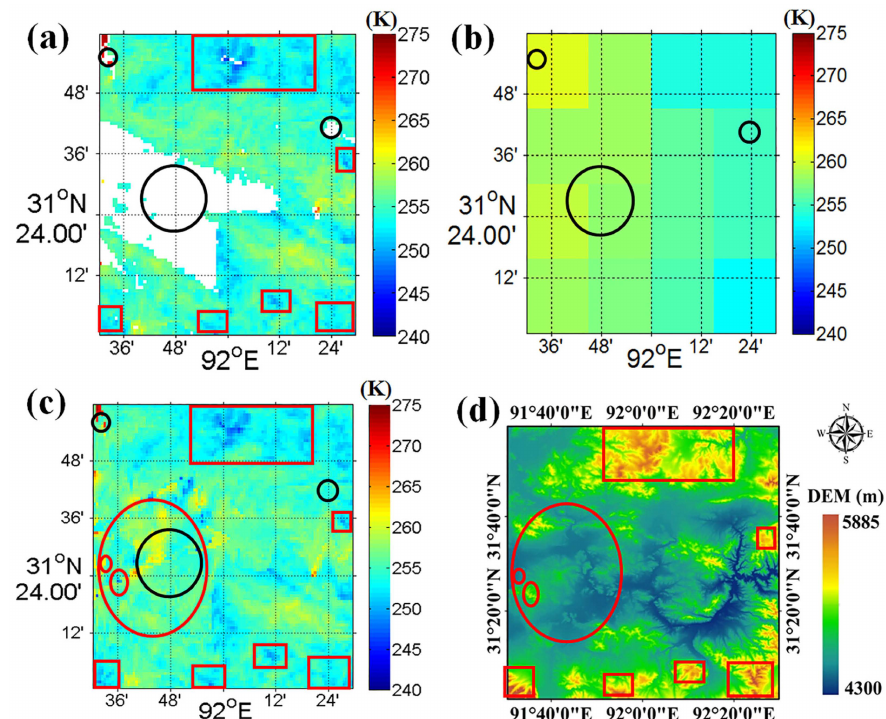
Figure 6. The spatial distribution of LSTs (in Kelvin) and elevation: ( a ) MODIS LST; ( b ) AMSR-E LST; ( c ) merged LST; and ( d ) elevation in the study area on 17 November 2010.